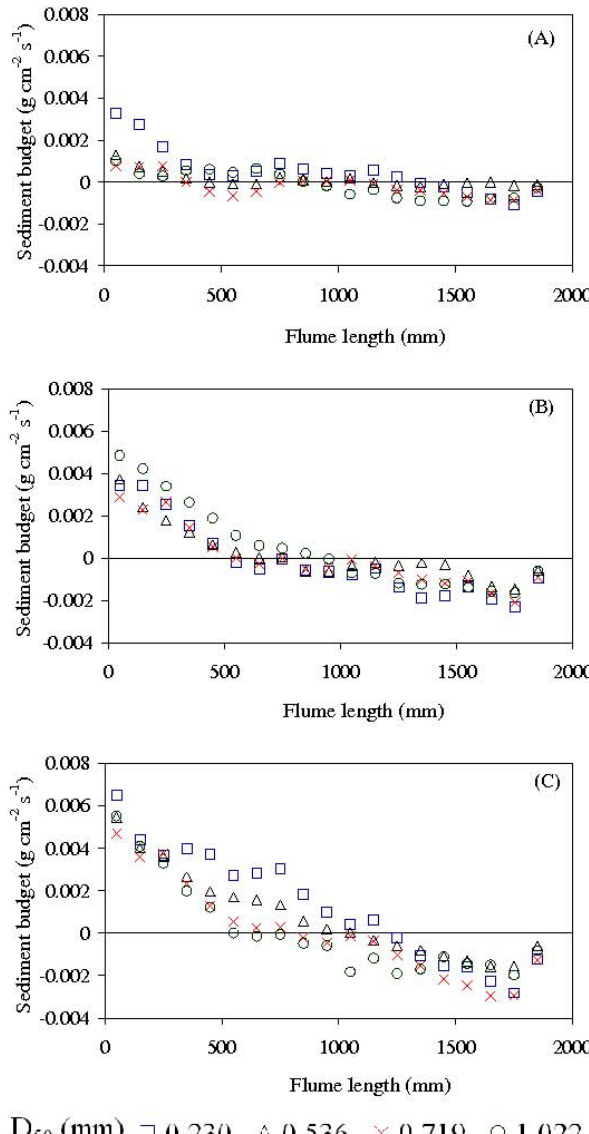
Fig. 2. Sediment budget along the flume length corresponding to unit discharges of (A) 0.17, (B) 0.33 and (C) 0.50 × 10 − 3 m 2 s − 1 at a slope of 13.2% for different grain size